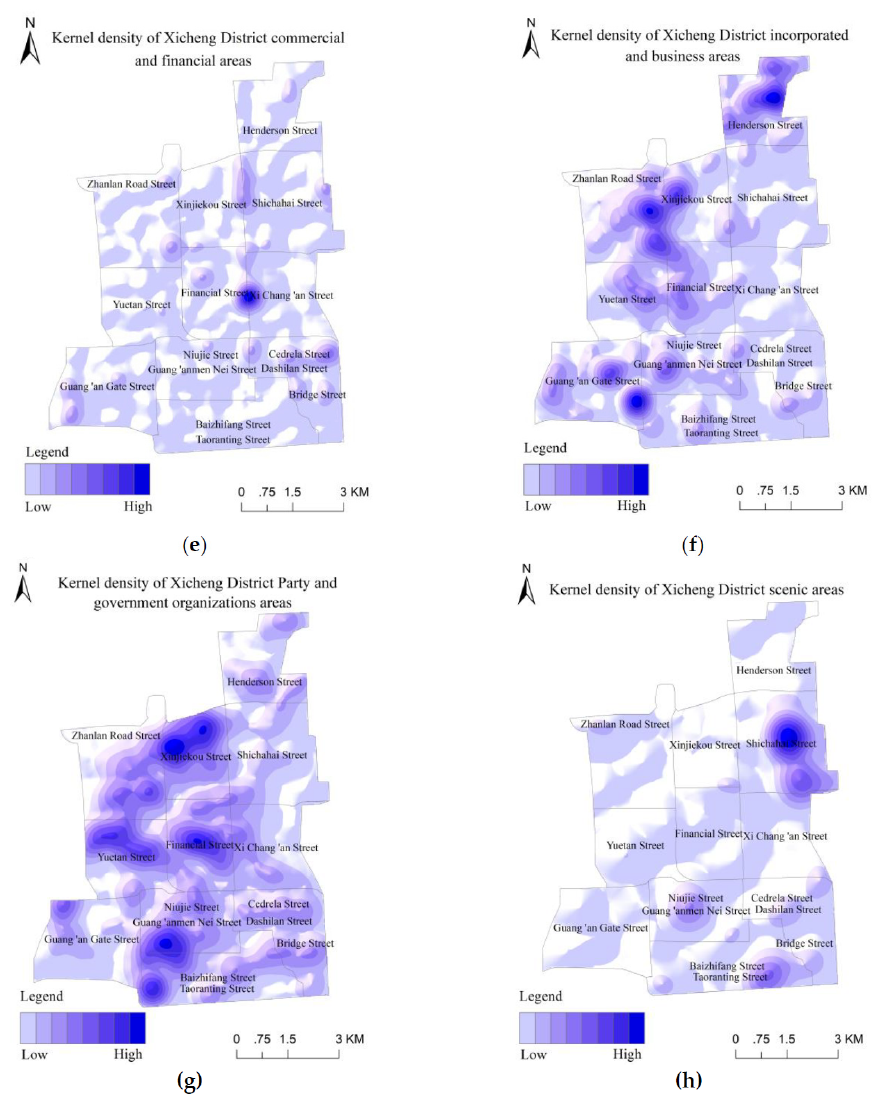
Figure 4. Kernel density analysis of point of interest (POI) data. Different types of POI data have different spatial distributions. Residential areas are distributed in the middle and south of the Xicheng District; they are concentrated at the junctions of Financial Street and Shichahai Street, Guang’anmen Nei Street and Taoranting Street, and Guang’an Gate Street. Education and training areas are distrib- uted in the northwest of the Xicheng District; they are concentrated on Zhanlan Road. Recreation and entertainment areas are distributed in the middle and northeast of the Xicheng District; they are concentrated at the junction of Financial Street and Shichahai Street. Medical and public health areas can be found along the central line extending from north–south in the Xicheng District. Commercial and financial areas are distributed in the middle of the Xicheng District; they are concentrated at the junction of Financial Street and Shichahai Street. Incorporated business areas can be found on Henderson Street in the northeast of the Xicheng District, at the junction of Xinjiekou Street and Zhanlan Road Street in the northwest, and at the junction of Guang’an Gate Street, Guang’anmen Nei Street, Niu- jie Street, Taoranting Street, and Baizhifang Street in the southwest. The distribution of party